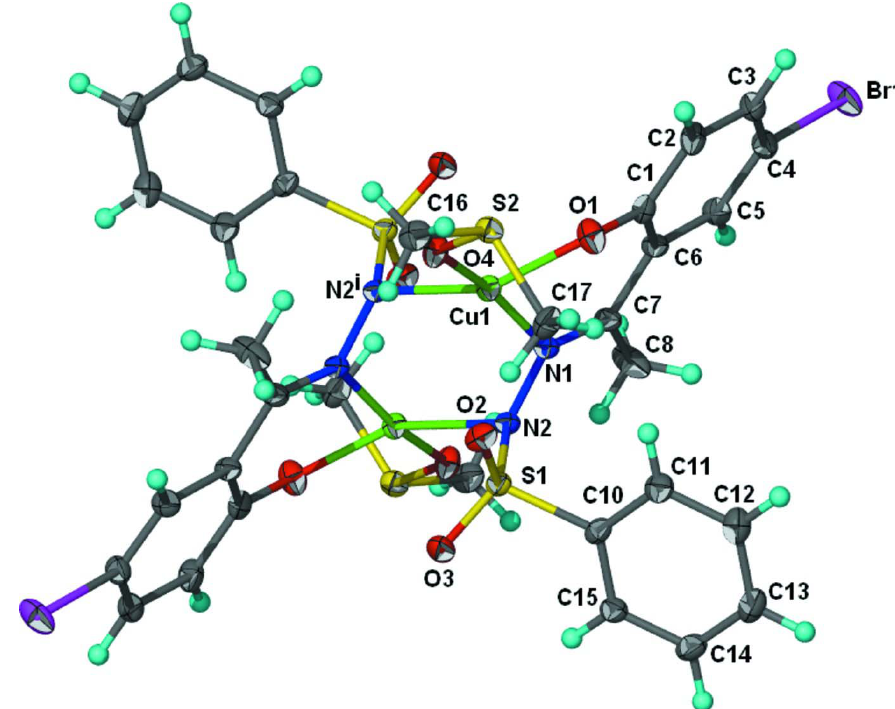
Figure 1 The molecular structure with displacement ellipsoids drawn at the 50% probability level, and H atoms shown as spheres of arbitrary radii [symmetry code: (i) - x + 2, - y + 1, - z